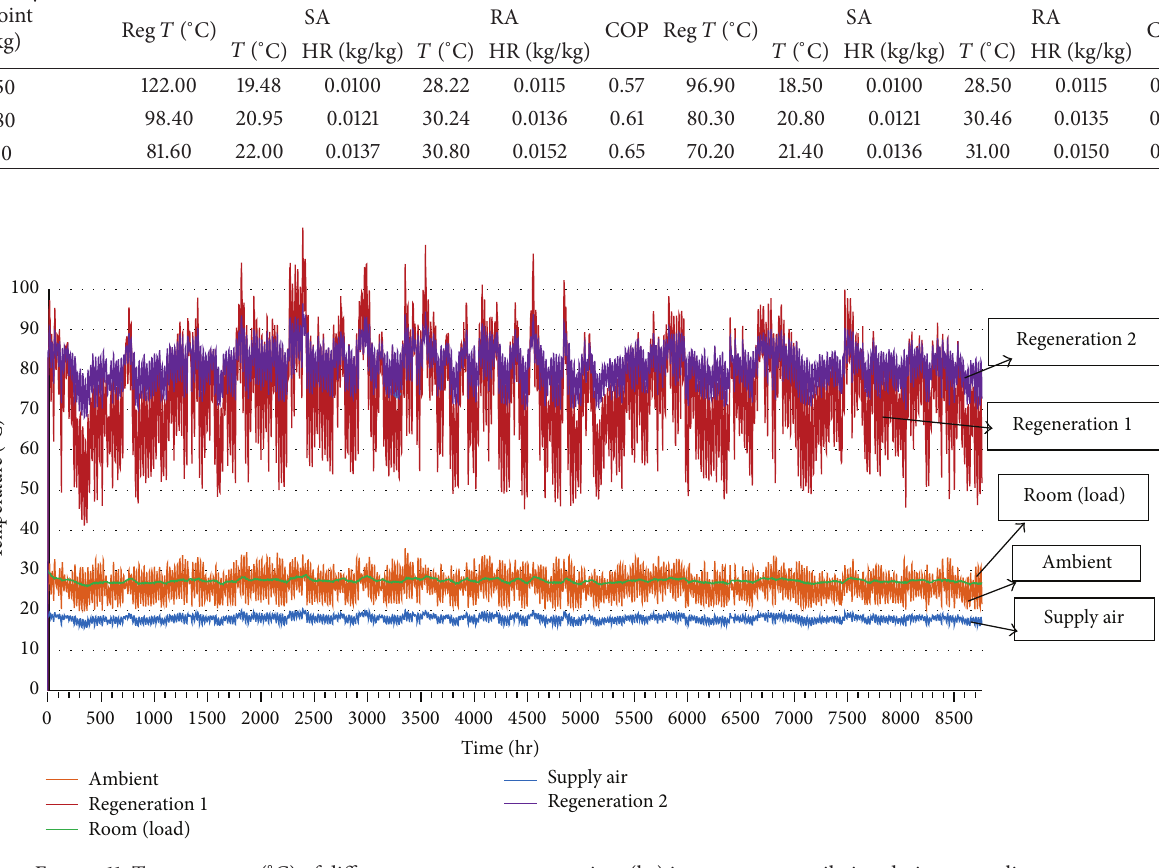
Table 4: Air properties results of ventilation and recirculation modes based on different humidity ratio set points. Humidity ratio